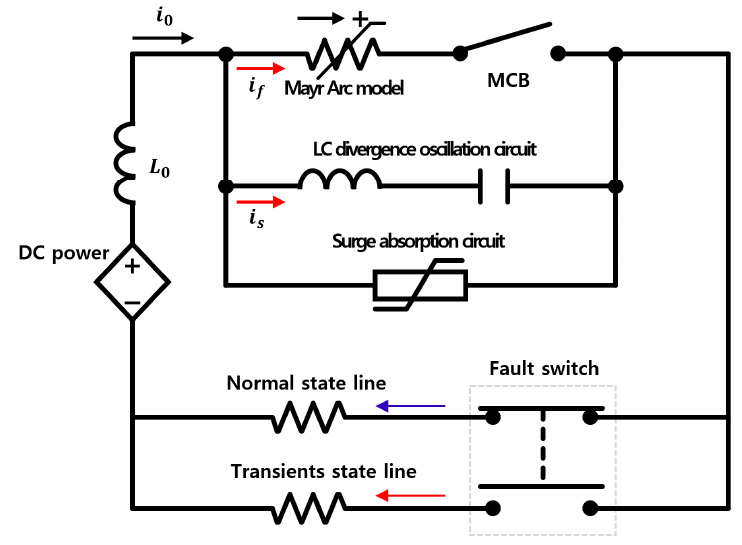
Figure 1. Simulation circuit structure of mechanical DC circuit breaker applying LC divergence oscillation method.